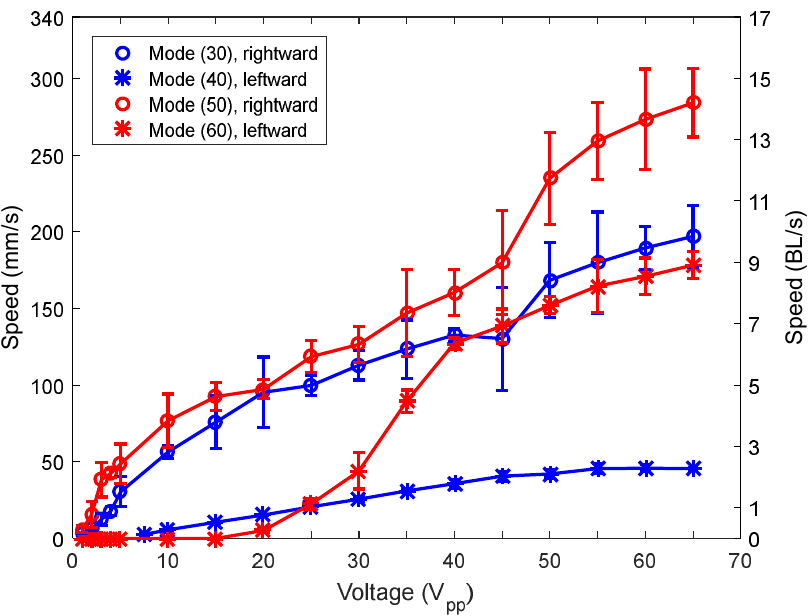
Figure 9. Speed of the robots versus applied voltage for mode (30), mode (40), mode (50) and mode (60).